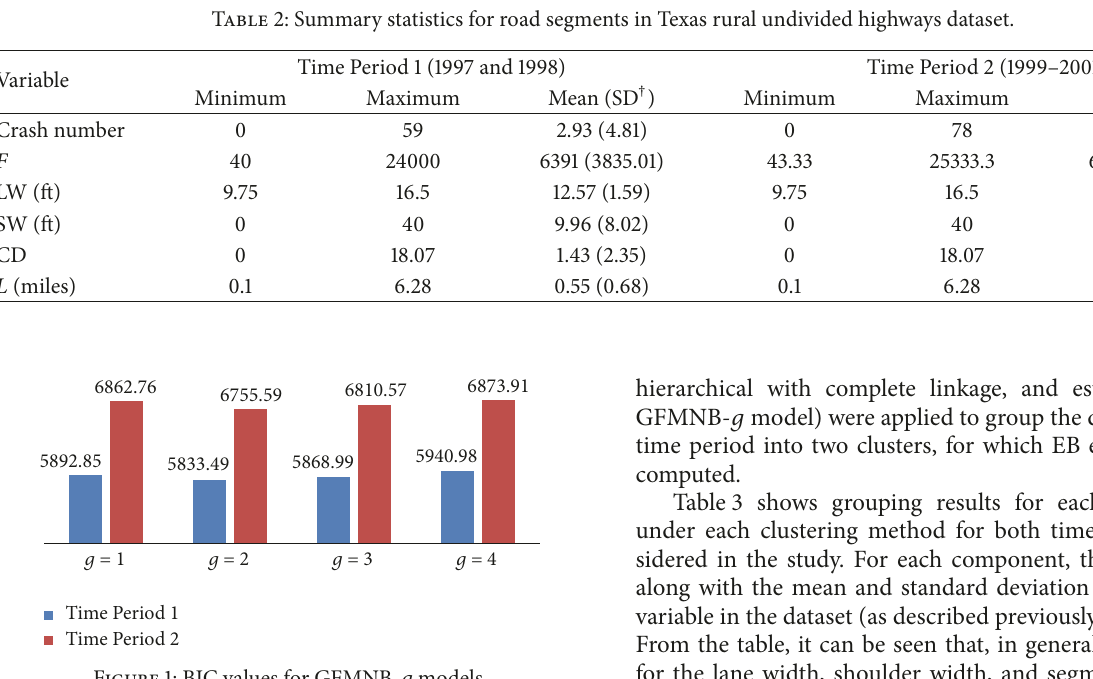
Figure 1: BIC values for GFMNB- 𝑔